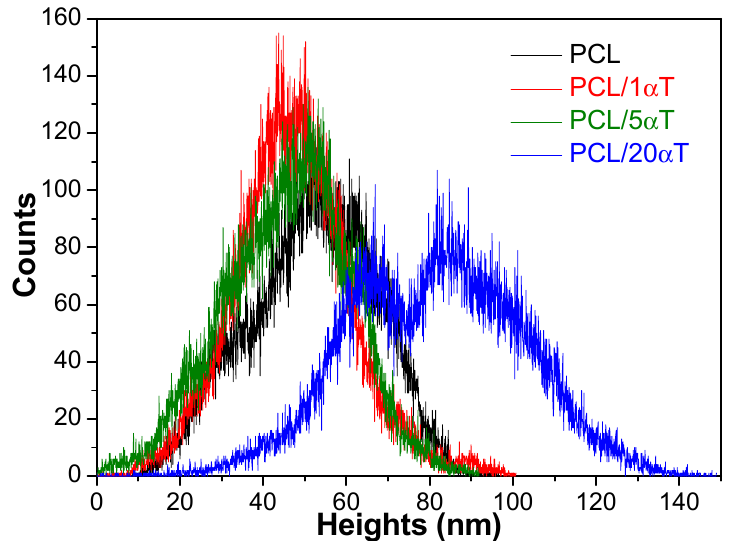
Figure 7. The heights histograms from the AFM micrographs of PCL/ α T fibers.